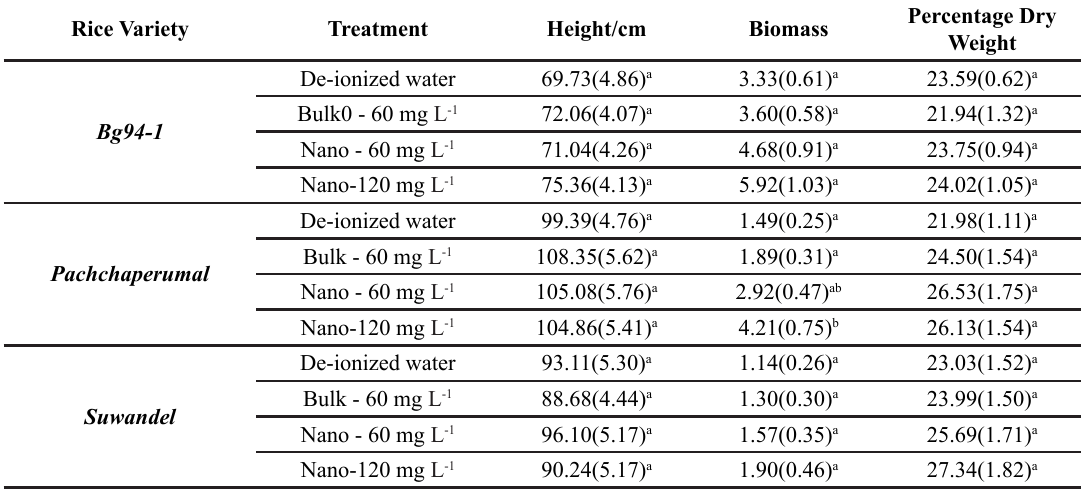
Table 1: Descriptive statistics of the parametric characteristics, plant height (cm), biomass, and percentage dry weight with treatments and rice